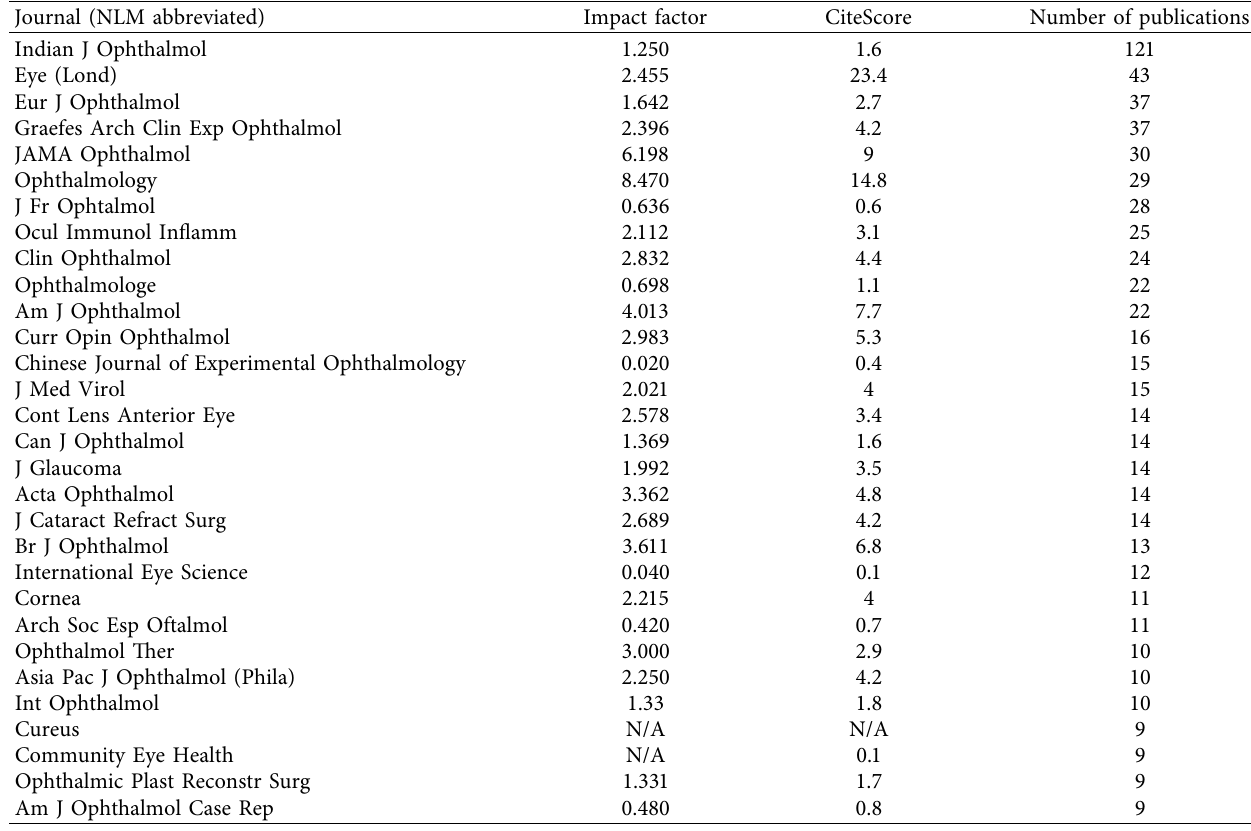
Table 1: The list of top 30 journals that published ophthalmology-focused articles, their Web of Science impact factor, CiteScore, and the number of publications.